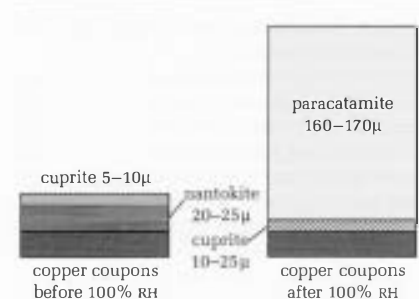
Figure 2 Copper coupons containing artificial copper-chloride corrosion. coupons in contact with 95 per cent rela­ tive humidity at ambient temperature pro­ duced paratacamite (Fig. 2). This is similar to the reaction that occurs on archaeolog­ ical artefacts containing chloride corrosion.